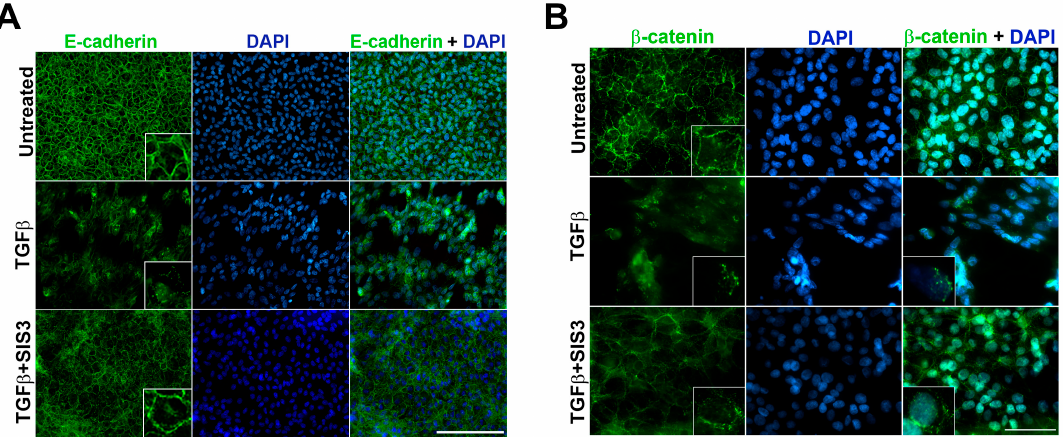
Figure 2. Localization of β -catenin and E-cadherin upon Smad3 inhibition. Rat lens explants were treated with TGF- β in the presence or absence of SIS3 for 48 h ( n = 3 where n ≥ 5 explants per treatment). PFA fixed explants were stained for ( A ) β -catenin and ( B ) E-cadherin and mounted with DAPI to visualize nuclei. Images were acquired using 40X lens of Leica DM6 fluorescence microscope. Scale bars set to 100 µ m. Inset shows partial inhibition of β -catenin delocalization (panel 3, B) but complete inhibition of E-cadherin delocalization (panel 3, A) in lens explants co-treated with TGF- β and SIS3.